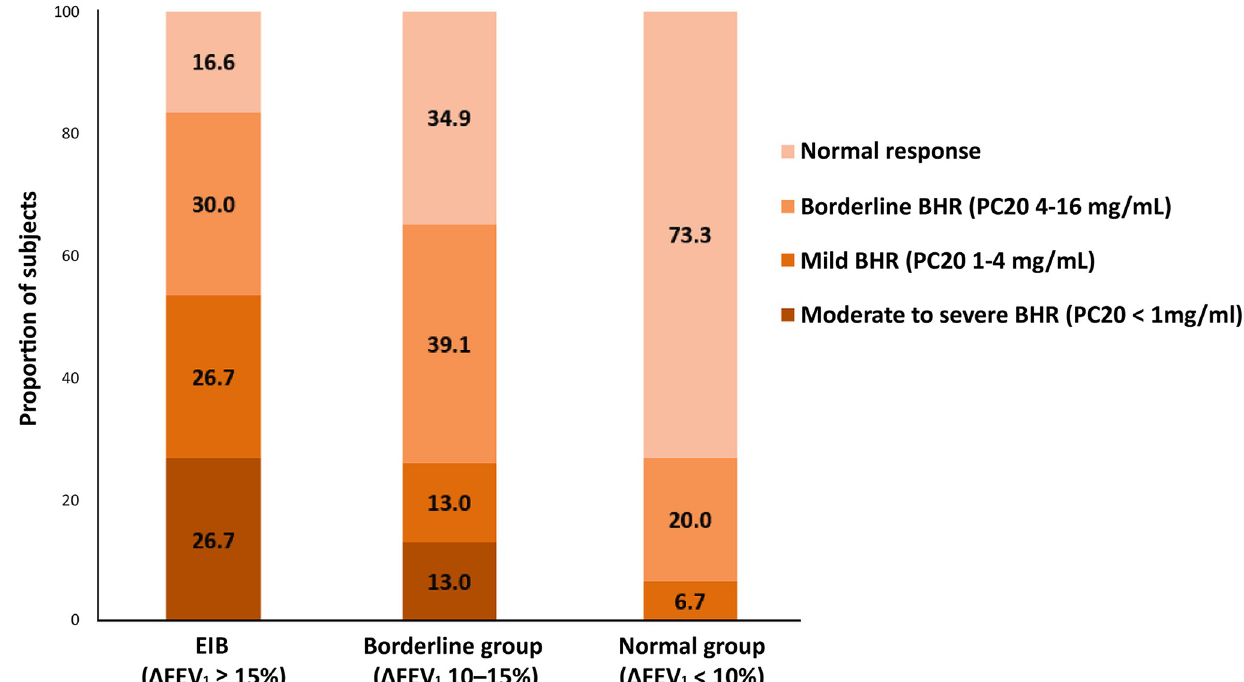
Fig 1. Proportion of patients according to the methacholine provocation test results.